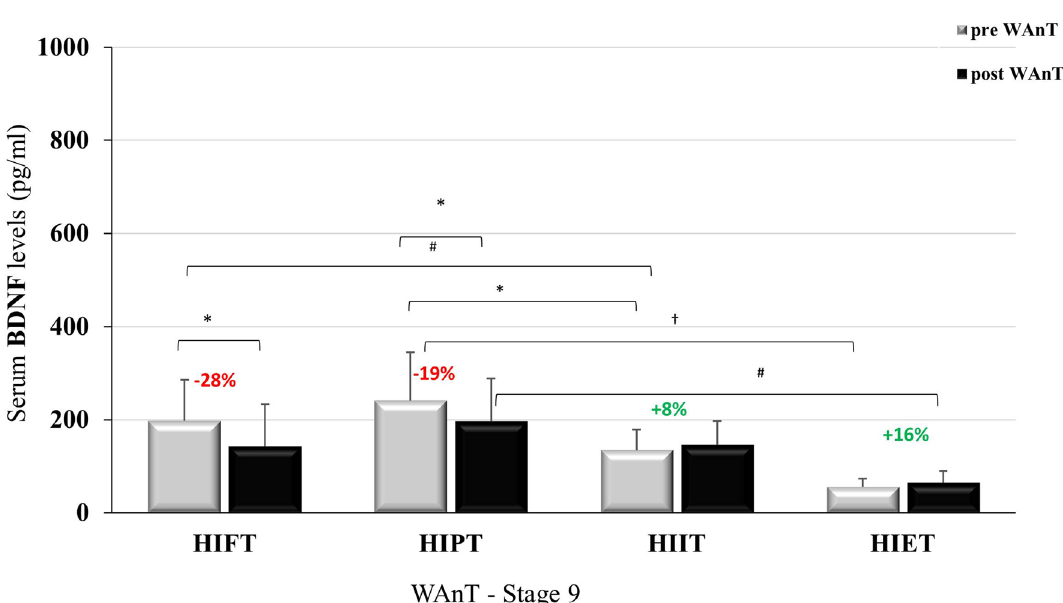
Figure 4. BDNF level in stage 9, -pre and post-WAnT; *p < 0,05; # p < 0,01; † p <